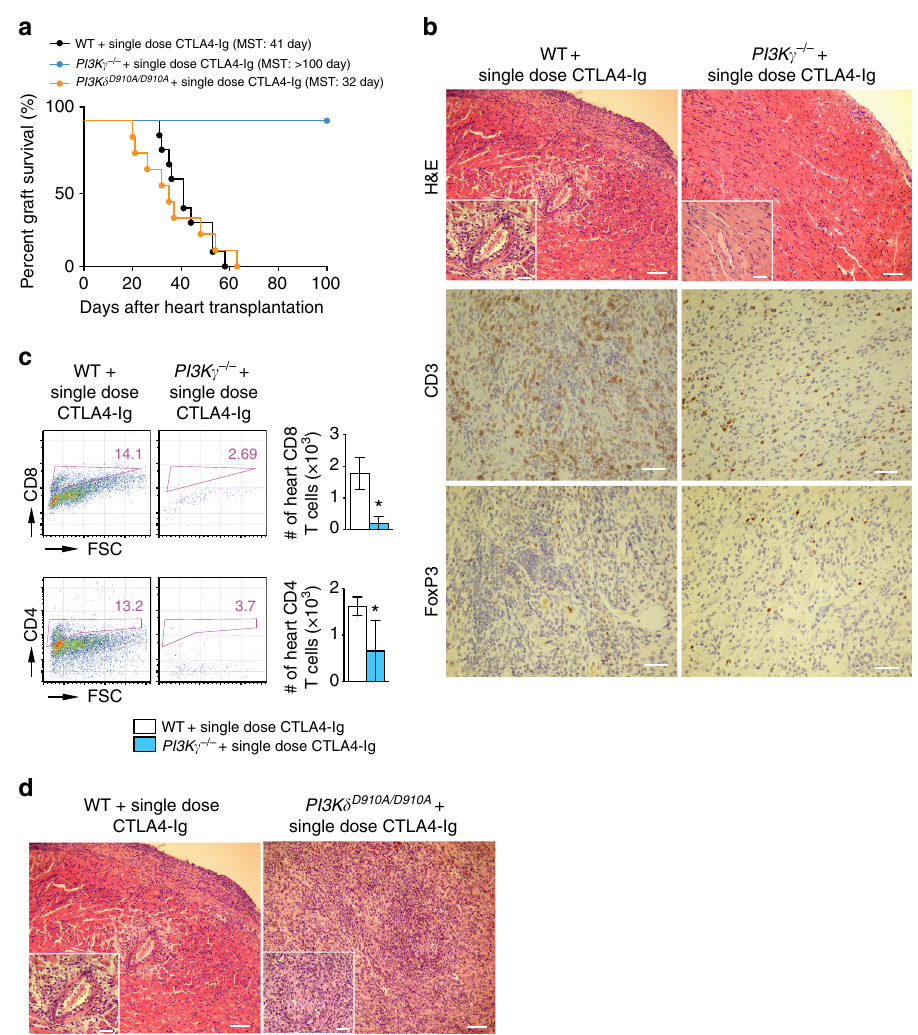
Fig. 3 PI3K γ or PI3K δ deletion and long-term allograft survival. a single dose CTLA4-Ig, injected into PI3K γ − / − recipients induced long-term acceptance of fully mismatched BALB/c cardiac allografts compared to the controls (MST of 41 vs. > 100 days, * p < 0.05, t -test, n = 10/group). However, single dose CTLA4-Ig, injected into PI3K δ D910A/D910A recipients of fully mismatched BALB/c cardiac allografts showed reduced allograft survival compared to the controls (MST: 41 vs. 32 days, * p < 0.05, t -test, n = 7 – 10/group). b Representative examples of cardiac allograft histology at day 100 post-transplant show lower grades of acute cellular rejection in the PI3K γ − / − hearts treated with single dose CTLA4-Ig compared to cardiac allograft at day 28 post-transplant from WT mice treated with single dose CTLA4-Ig ( n = 4/group). Inset show worse vasculopathy in the WT recipients treated with single dose CTLA4-Ig compared to PI3K γ − / − hearts treated with single dose CTLA4-Ig (H&E stain, scale bar 50 μ m, inset scale bar 25 μ m). Immunohistochemistry analysis of CD3 and FoxP3 shows fewer CD3+ in fi ltrating cells in the PI3K γ − / − hearts treated with single dose CTLA4-Ig compared to WT but relatively more FoxP3 ( scale bar 50 μ m). c Representative dot plots of leukocytes isolated from the allograft of PI3K γ − / − and WT recipients treated with single dose CTLA4-Ig show signi fi cantly less CD4 + and CD8 + in fi ltration in the PI3K γ − / − allografts compared to WT. Bar graph represents the absolute count of CD4 + and CD8 + T cells in the heart allografts of PI3K γ − / − and WT recipients treated with single dose CTLA4-Ig. (* p < 0.05, t -test, n = 6/group, the graphs show data as mean ± s. e.m.). d Representative examples of cardiac allograft histology at day 28 post-transplant show higher grades of acute cellular rejection in the PI3K δ D910A/ D910A hearts treated with single dose CTLA4-Ig compared to WT mice treated with single dose CTLA4-Ig ( n = 4/group). Inset show more severe vasculitis in the PI3K δ D910A/D910A treated with single dose CTLA4-Ig compared to WT-recipient hearts treated with single dose CTLA4-Ig (H&E stain, scale bar 50 μ m, inset scale bar 25 μ m). (MST mean survival